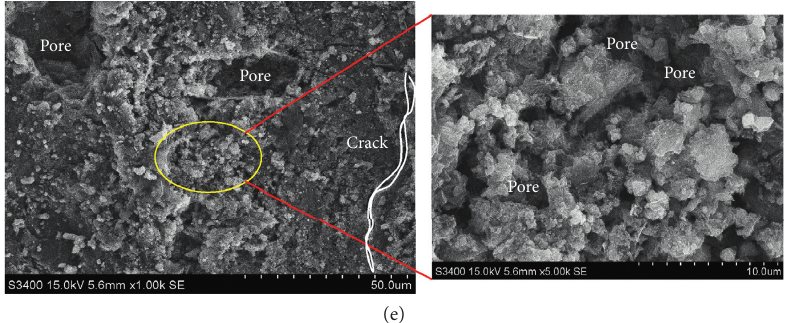
Figure 8: Mesomorphological and mineral crystal analysis of GTC (0% to 40%) based on SEM (solid, 1.0 k to 5.0 k). (a) GTC-0; (b)